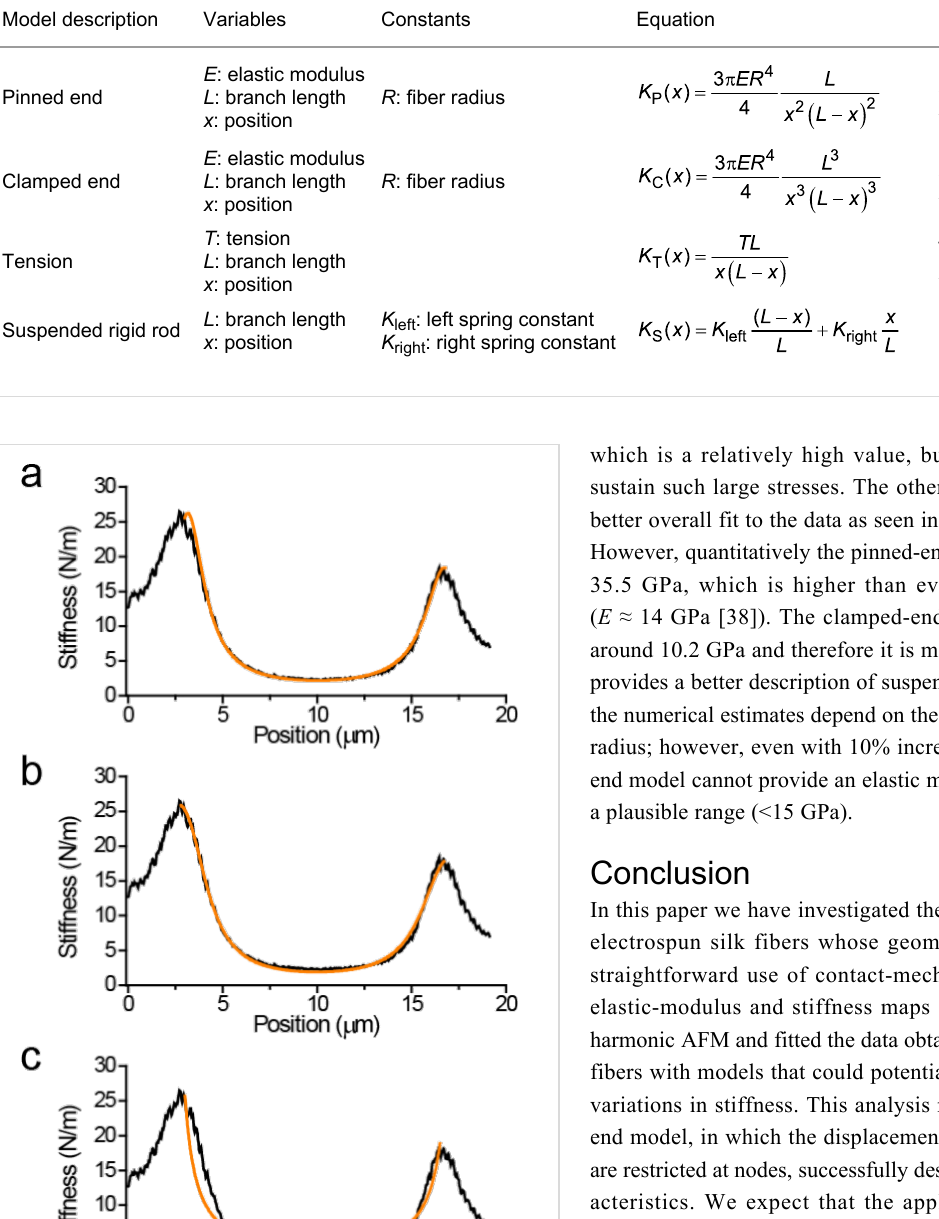
Table 1: Description of the variables and equations for spring constants based on the four mechanical models depicted in Figure 3. The values of variables calculated by curve fitting are given in the last column. Standard errors are given in parenthesis with the same units. Model description